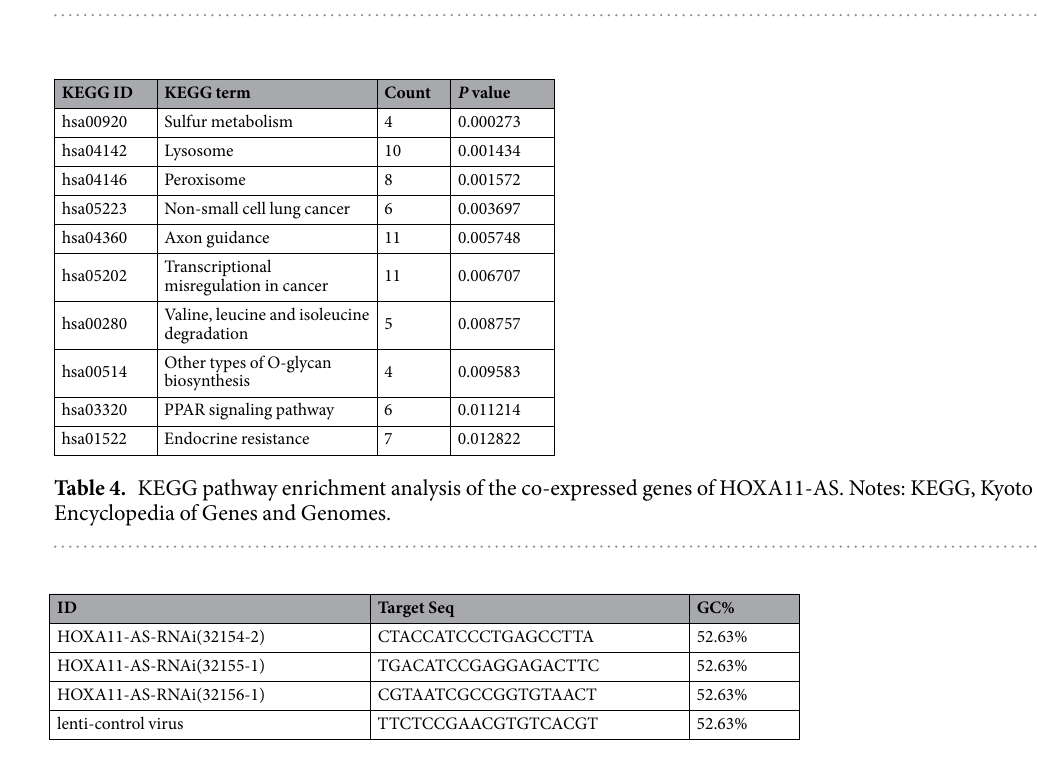
Table 5. The sequences of HOXA11-AS